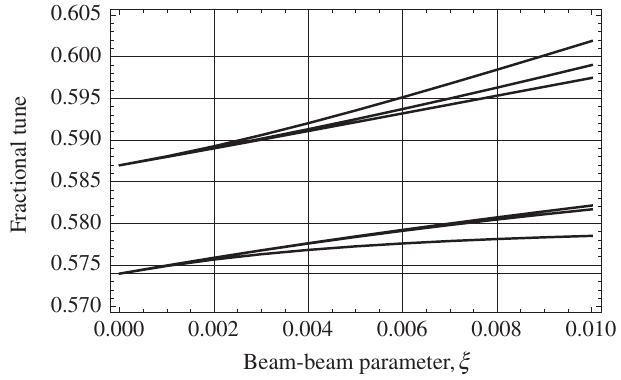
FIG. 1. Coherent mode tunes vs beam-beam parameter calculated with the linearized model; Q p ¼ 0 : 587 , Q a ¼ 0 : 574 , (cid:4) ¼ (cid:4) p ¼ (cid:4) a